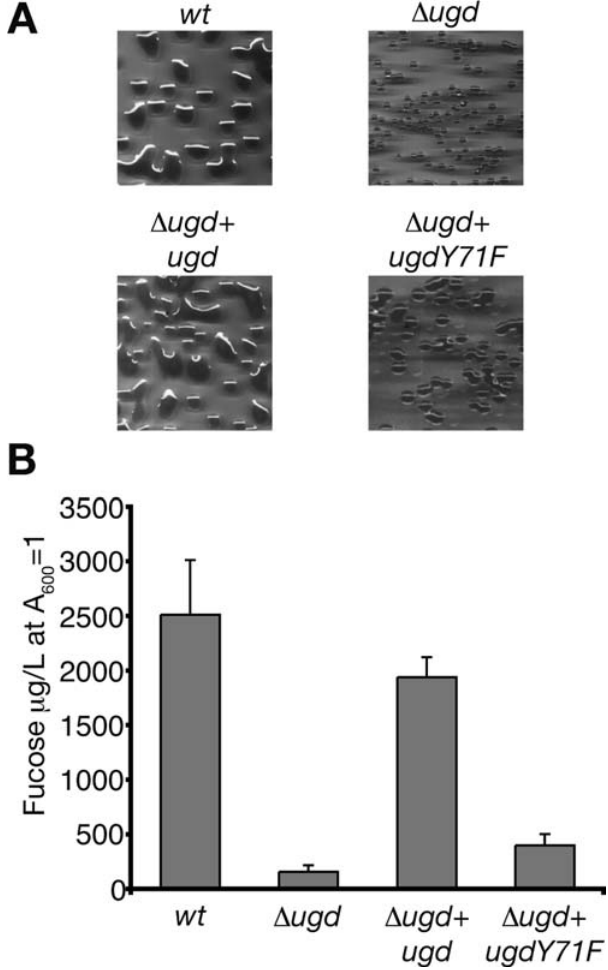
Figure 3. Influence of Ugd Tyr71 phosphorylation on colanic acid production. (A) Colony morphology of E. coli wt and mutants. Photographs were taken after growth on LB Agar plates for 24 h at 37 u C. (B) Production of colanic acid by wild-type E. coli and mutants. The amount of colanic acid was determined in each strain by measuring fucose, and was expressed as m g/L of culture of A 600 =1. Standard deviations from four independent experiments are indicated with error